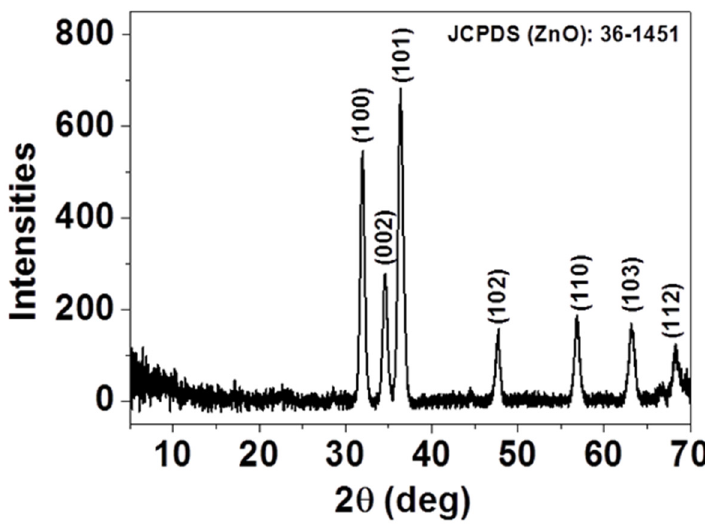
Figure 1. XRD of as-deposited ZnO thin film.